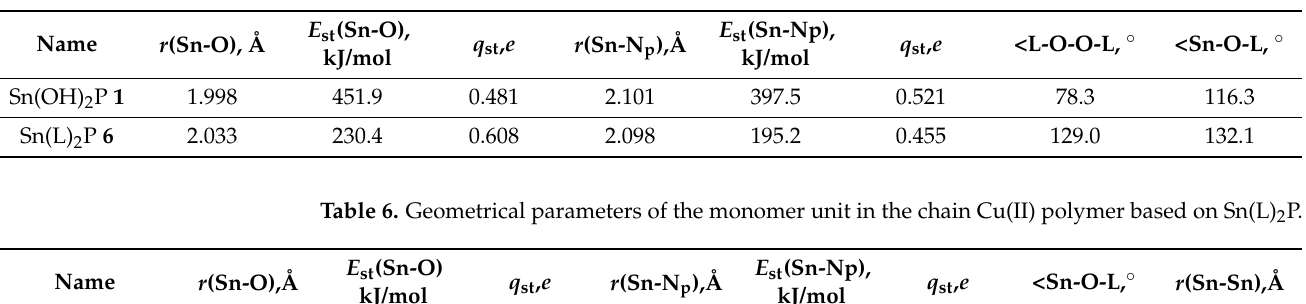
Table 5. Geometric parameters of the diaxial complexes based on Sn(IV)-diphenyldipyridylporphyrines.